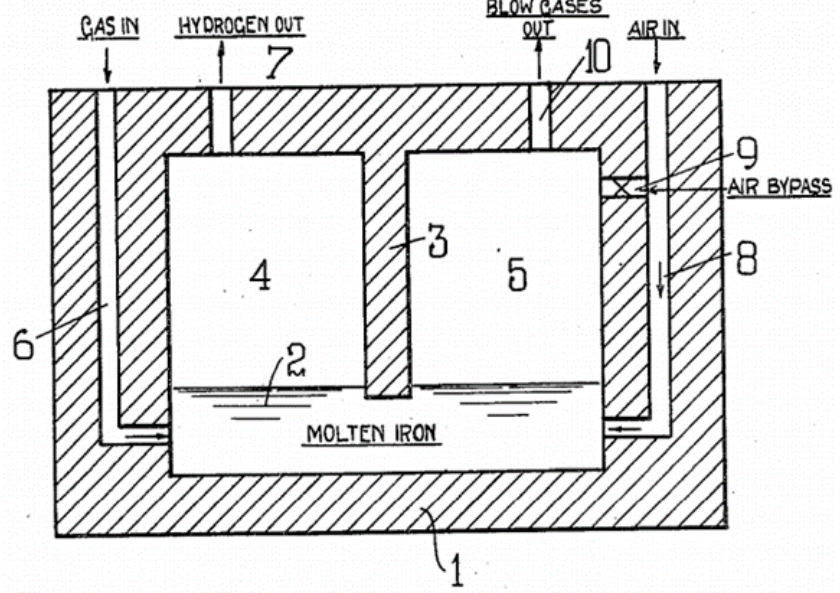
Figure 2. Two-chamber reactor design for pyrolysis in molten media from US patent of Tyrer (Copied from Ref. [29]).